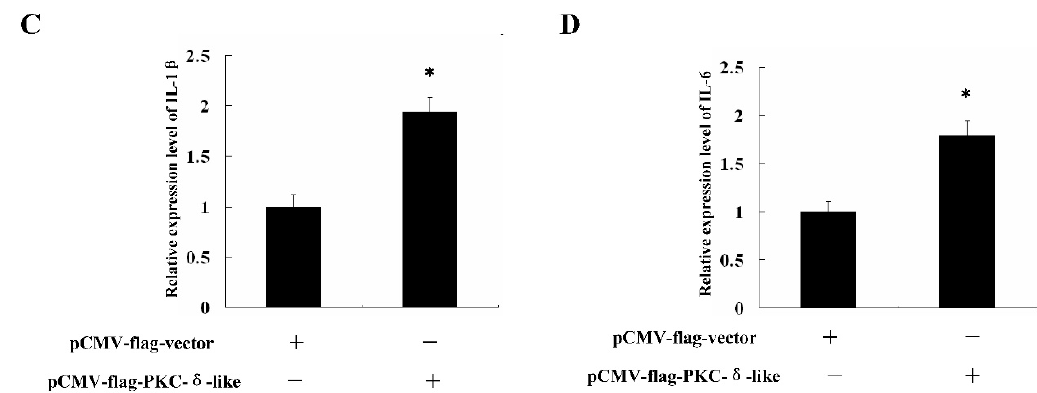
Figure 2. The e ff ect of over-expression of PKC- δ -like on the cellular inflammation reaction. ( A ) The protein expression of PKC- δ -like in the RAW264.7 cells was detected. ( B ) The mRNA levels of TNF- α in the RAW264.7 cells, which were transfected with PKC- δ -like, were detected. ( C ) The mRNA levels of IL-1 β in the RAW264.7 cells, which were transfected with PKC- δ -like, were detected. ( D ) The mRNA levels of IL-6 in the RAW264.7 cells, which were transfected with PKC- δ -like, were detected. The asterisk indicates p < 0.05.